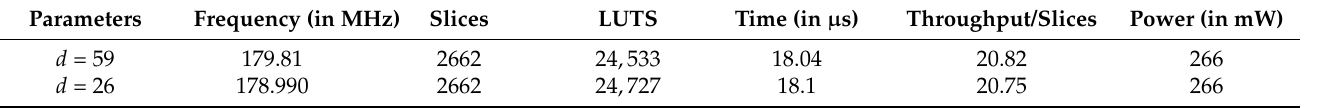
Table 4. Results after synthesis over GF ( 2 233 ) on Xillinx Virtex-7